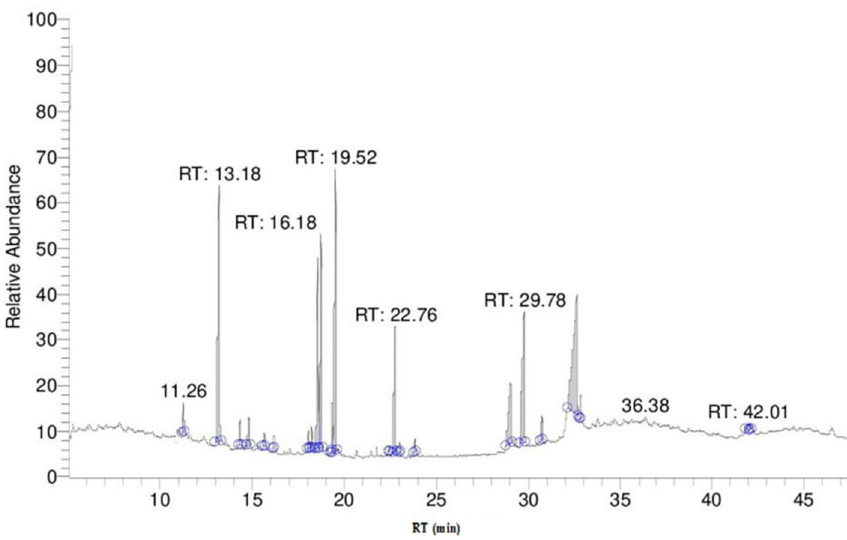
Figure 3. Gas chromatography spectra of biologically active compounds of Acacia nilotica